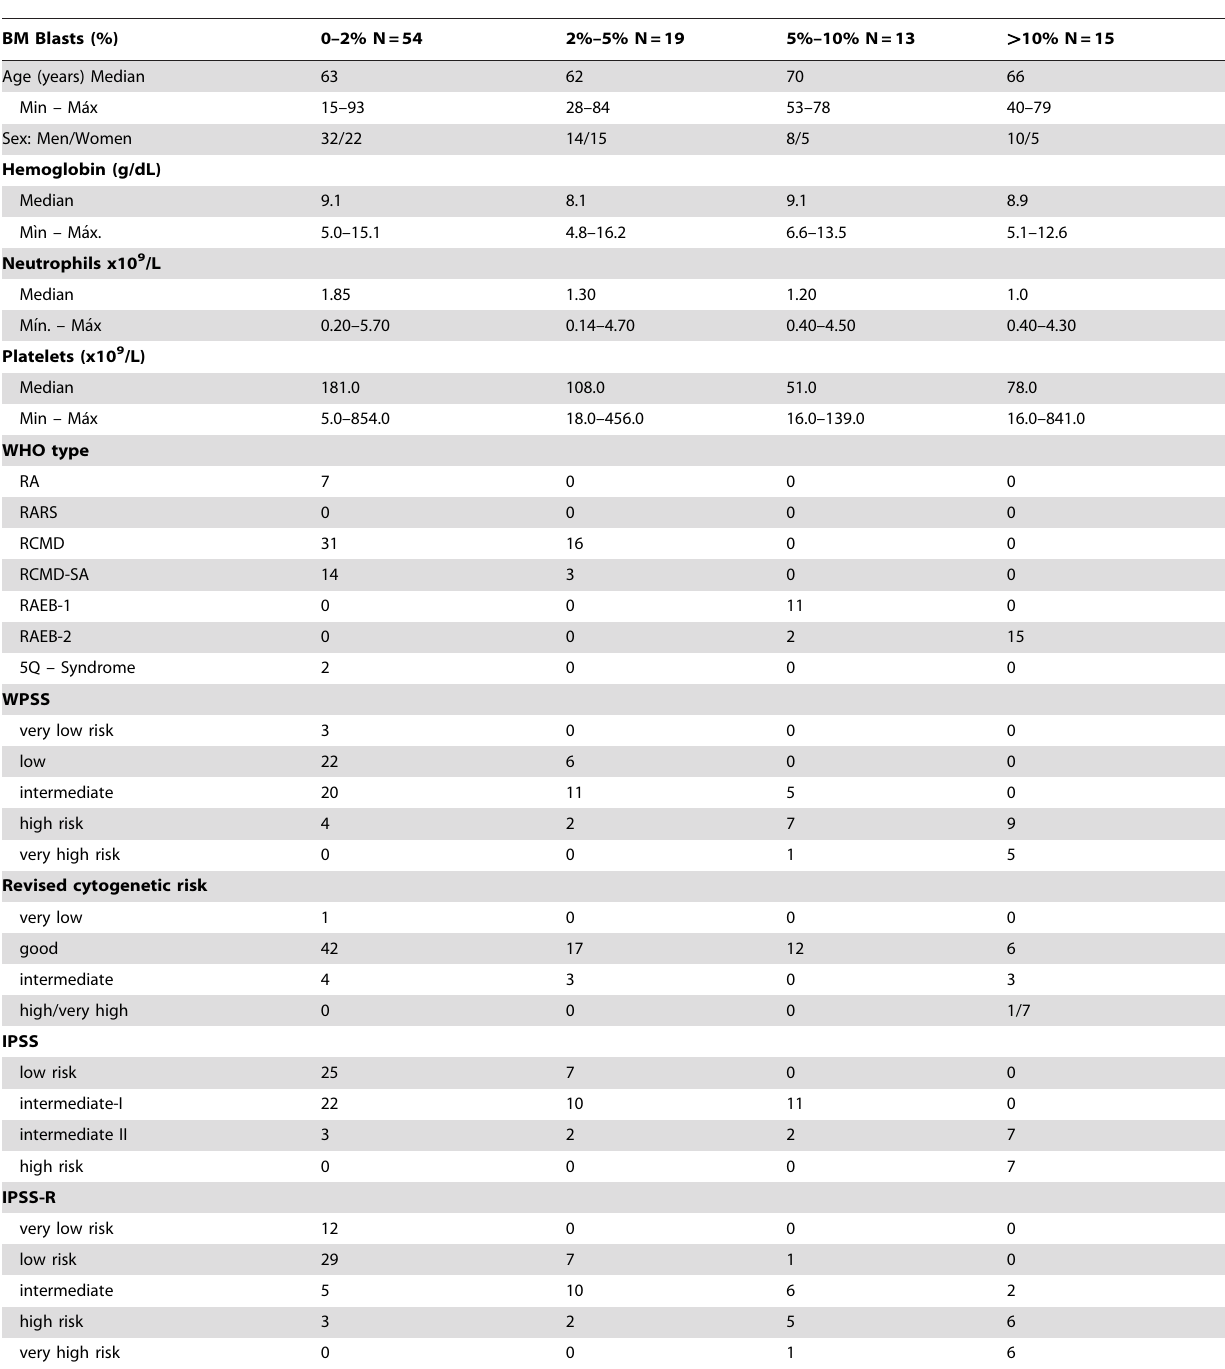
Table 2. Clinical features, PB counts and prognostic scores of the